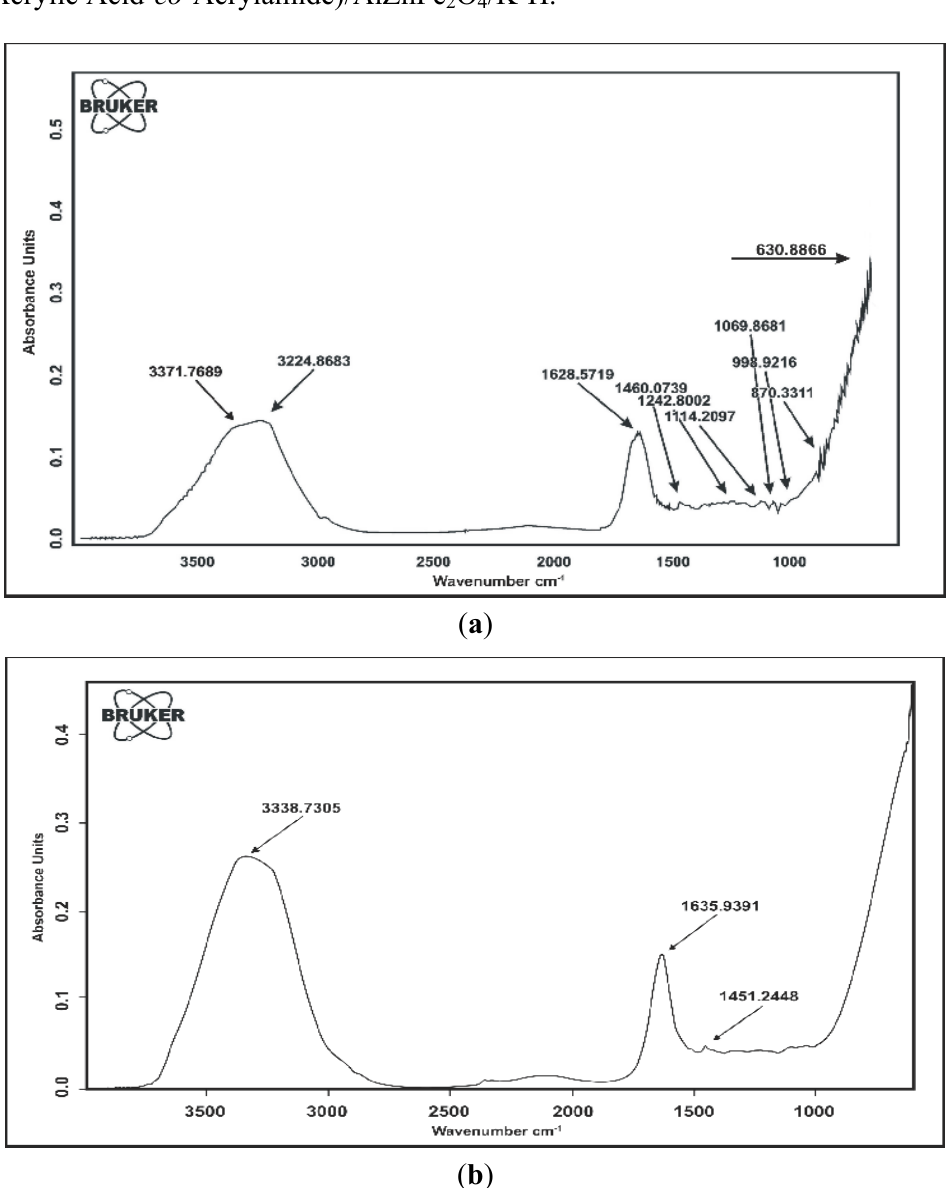
Figure 4. ( a ) FTIR spectrum of poly(acrylic acid- co -acrylamide); ( b ) FTIR spectrum